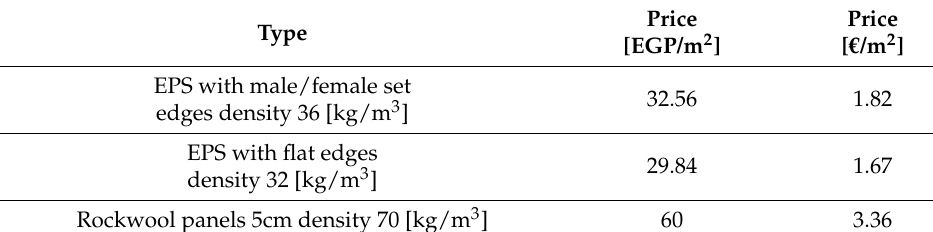
Table A2. Expanded polystyrene (EPS) dimensions and prices in Egypt.